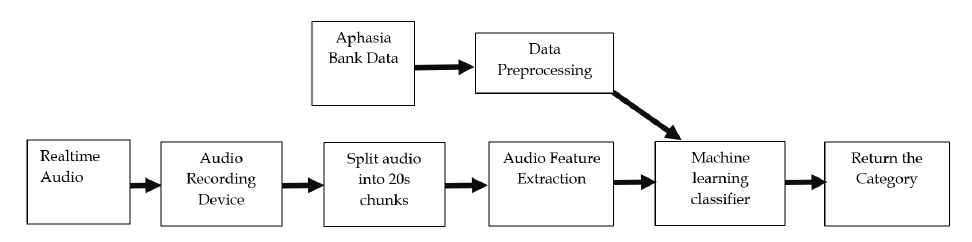
Figure 1. Aphasia classification model block